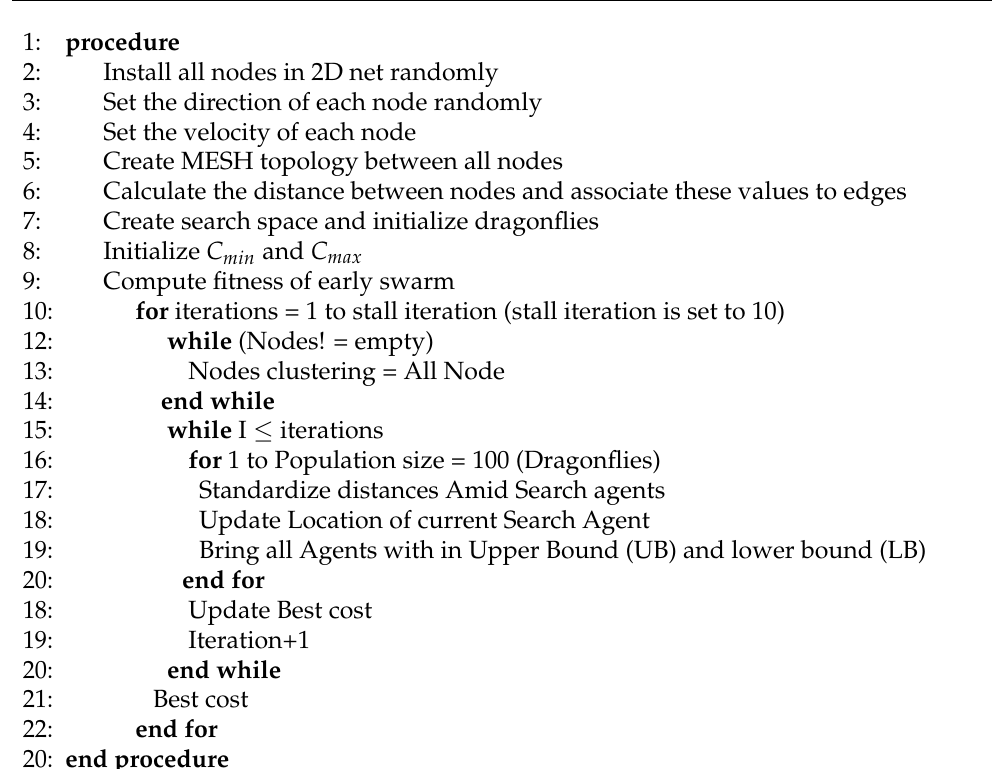
Algorithm 1. Dragon Fly Optimization based algorithm for